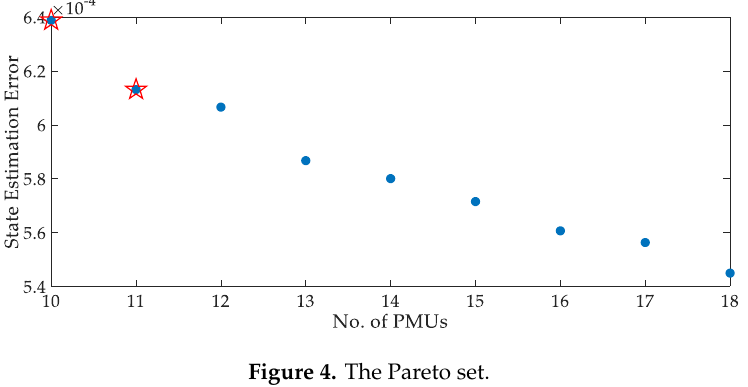
Figure 4. The Pareto set.